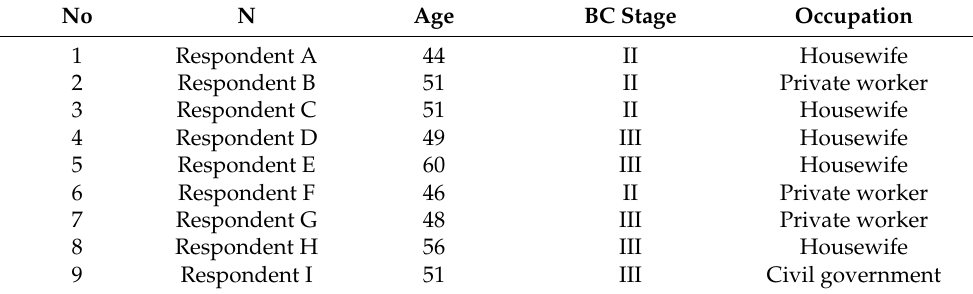
Table 1. Characteristics of